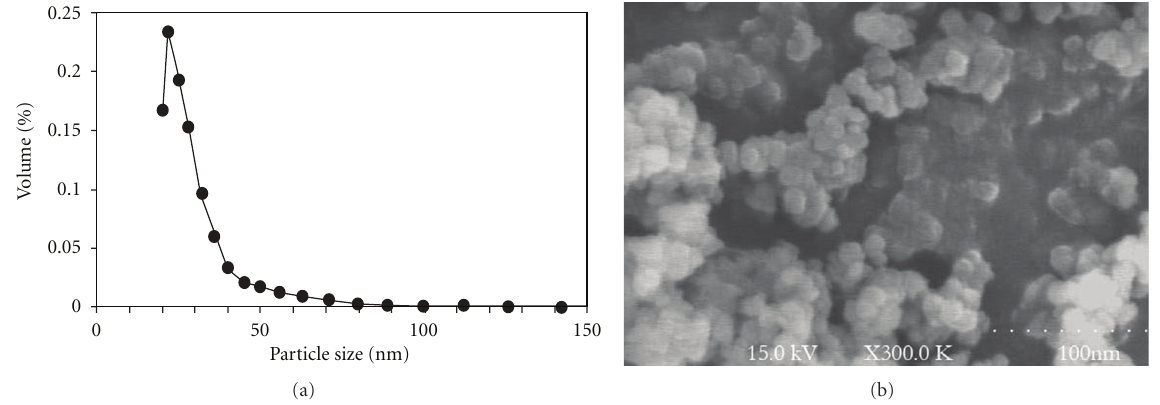
Figure 3: FESEM image and particle size distribution of nano-TiO 2 patricle.